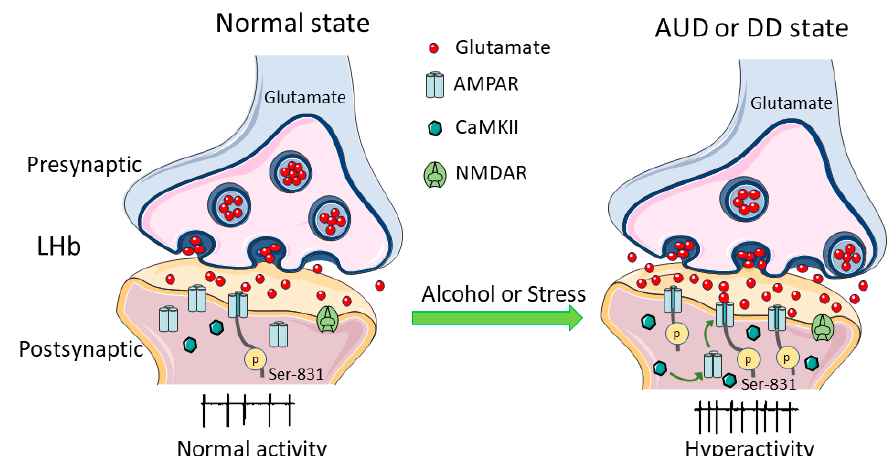
Figure 2. Changes of calcium / calmodulin-dependent protein kinase II (CaMKII) signaling in the LHb glutamatergic neurons in alcohol use disorders (AUDs) and depressive disorders (DDs). Withdrawal from chronic alcohol administration and stress enhance glutamatergic transmission to and the spike output of LHb neurons. This is due in part through phosphorylating serine 831 (Ser831) on the glutamate A1 (GluA1) subunit and activating the CaMKII.